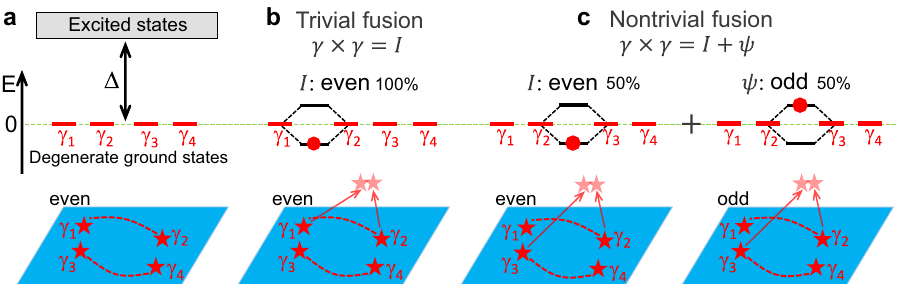
Fig. 1 Schematic of the fusion rules. a Topological superconductor (blue) hosting MBS, γ 1,...,4 . They behave as non-Abelian anyons and lead to the fourfold degeneracy in topological ground states, separated by the energy gap, Δ , from the trivial excited states. b , c Different fusion outcomes: trivial fusion of γ 1 and γ 2 , 100% probability to access vacuum, I (Cooper pair condensate), and nontrivial fusion of γ 2 and γ 3 , equal probabilities to access I or an unpaired fermion, ψ . Red dashed lines: paired MBS. In each case bringing closer MBS leads to the level splitting from the initial zero-energy modes. Filling the lower level, corresponding to I with even parity, means the absence of a given particle while fi lling the upper level refers to ψ with odd parity. We assume initially even parity of the system. The net change in the charge characterizes the nontrivial